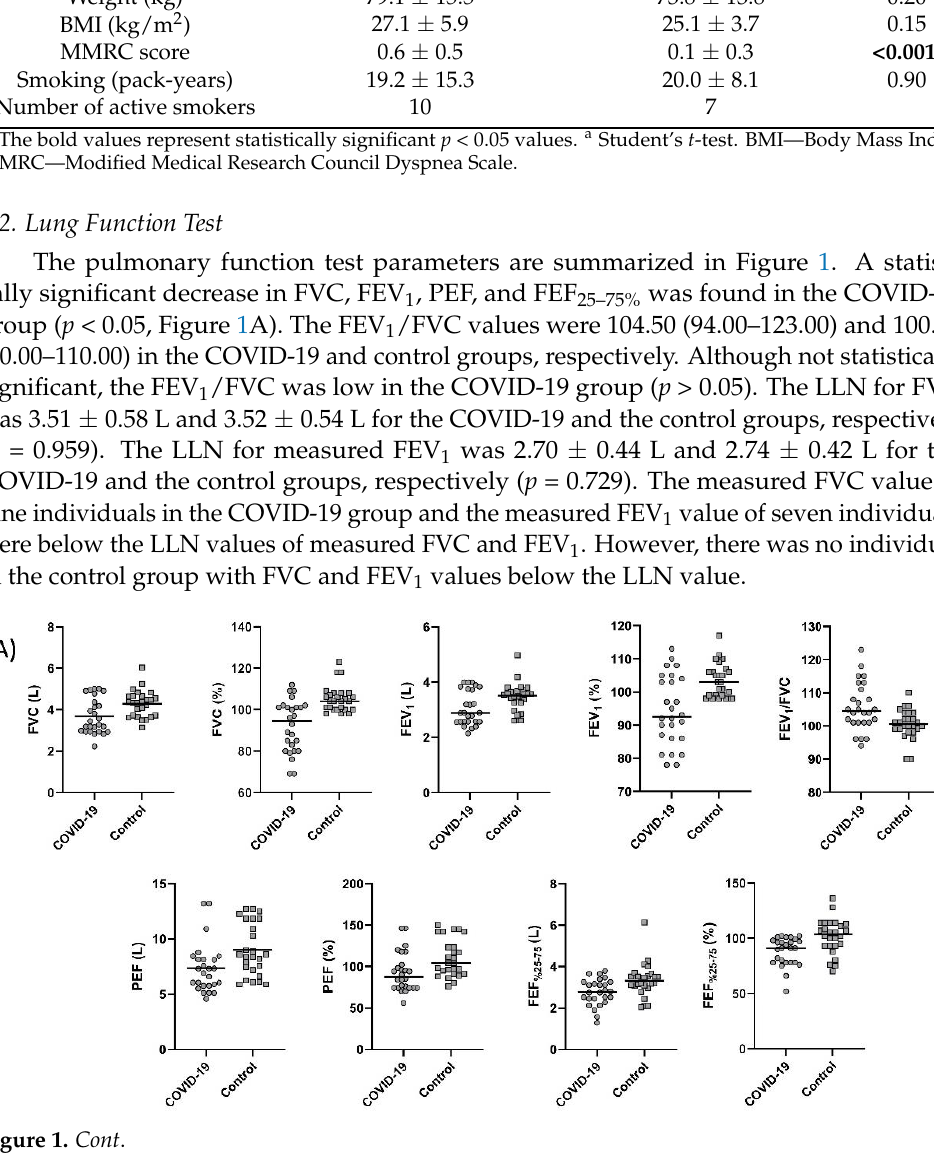
Figure 1. Comparison of ( A ) forced vital capacity (FVC) ( p = 0.005), percent predicted FVC ( p < 0.001), forced expiratory volume in one second (FEV 1 ) ( p = 0.04), percent predicted FEV 1 ( p = 0.001), FEV 1 /FVC ( p = 0.255), peak expiratory flow (PEF) ( p = 0.01), percent predicted PEF ( p = 0.007), forced expiratory volume from 25 to 75% (FEF 25 – 75% ) ( p = 0.01), percent predicted FEF 25 – 75% ( p = 0.001), ( B ) percent predicted maximum inspiratory pressure (MIP) ( p = 0.38), percent predicted maximum ex- piratory pressure (MEP) ( p = 0.46), ( C ) percent predicted quadriceps strength ( p < 0.001), and percent predicted handgrip strength ( p = 0.048) between the COVID-19 and control groups. 3.3. Respiratory and Peripheral Muscle Strength Respiratory and peripheral muscle strength values are shown in Figure 1. MIP and MEP were similar between the groups ( p > 0.05, Figure 1B). Handgrip strength and quad- riceps muscle strength values were significantly lower in the COVID-19 group ( p < 0.05, Figure 1C). The 15 (57.6%) subjects from the COVID-19 group had quadriceps strength lower than the 95% confidence interval of the controls. 3.4. Functional Capacity Evaluation A comparison of 6MWT distance values in the COVID-19 and control group is sum- marized in Figure 2. In the COVID-19 and control groups, 6MWT distance was 561.1 ± 71.0 m and 652.6 ± 53.4 m, respectively (Figure 2A, p < 0.05). The 6MWT distance of the 21 (80.7%) subjects from the COVID-19 group was lower than the controls ’ 95% confidence interval (631.0 – 674.1 m). SpO 2 value measured during 6MWT was significantly lower (Fig- ure 2B), and general fatigue, leg fatigue, and dyspnea scores measured were significantly higher in the COVID-19 group after the test (Figure 2C, p < 0.05).